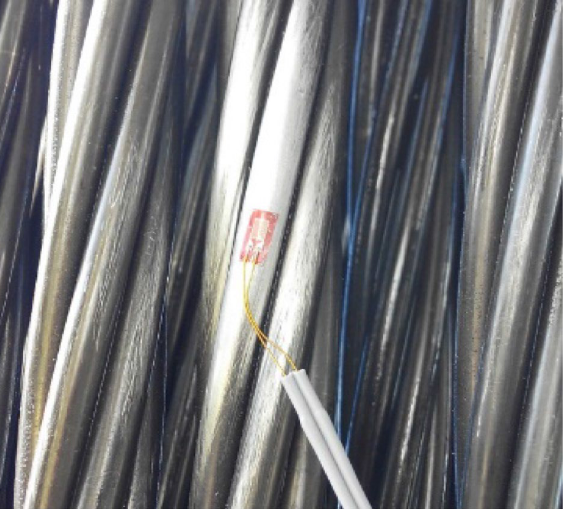
Figure 6. Installation of unidirectional strain gauges on one of the wires of a strand in a temporary cable.